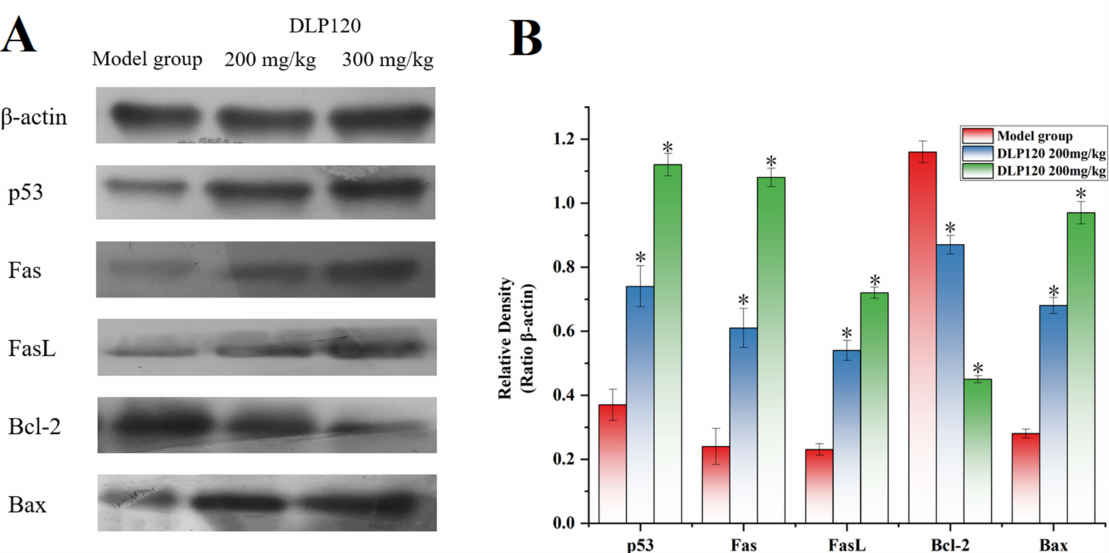
Figure 9. Expression of p53, Bax, Bcl-2, Fas, FasL and β -action of the model group and DLP120 group ( A ), and quantitative analysis ( B ). Note: * p < 0.05, compared to model